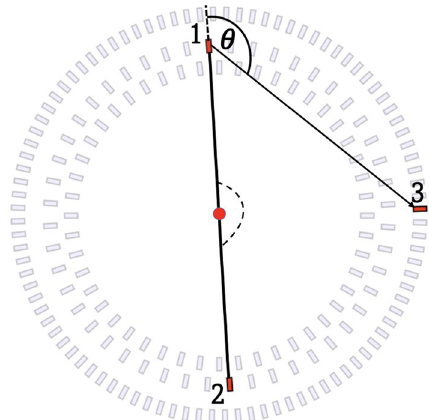
Fig. 6 The definition of the analyzed events with 3 hits is displayed. Of the 3 hits, the first two hits (1,2) were caused by counter‑propagating 511 keV photons. The third hit (3) represents the interaction by a scattered 511 keV photon. Here we see the association of the scattered photon (3) with the 511 keV photon marked 1, which gives us access to the scattering angle. However, the scattered photons are associated with the primary 511 keV photons based on the scatter test S , which can be described as the difference between (cid:31) t ij − D ij /c), where ij represents the pair of primary and scattered measured times and calculated times ( S = photon, (cid:31) t ij is the measured time difference, D ij is the distance between a pair of hits (31 or 32) and c is